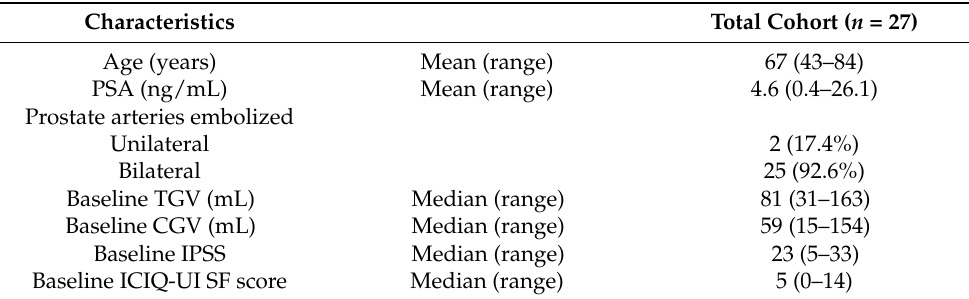
Table 2. Baseline characteristics of study